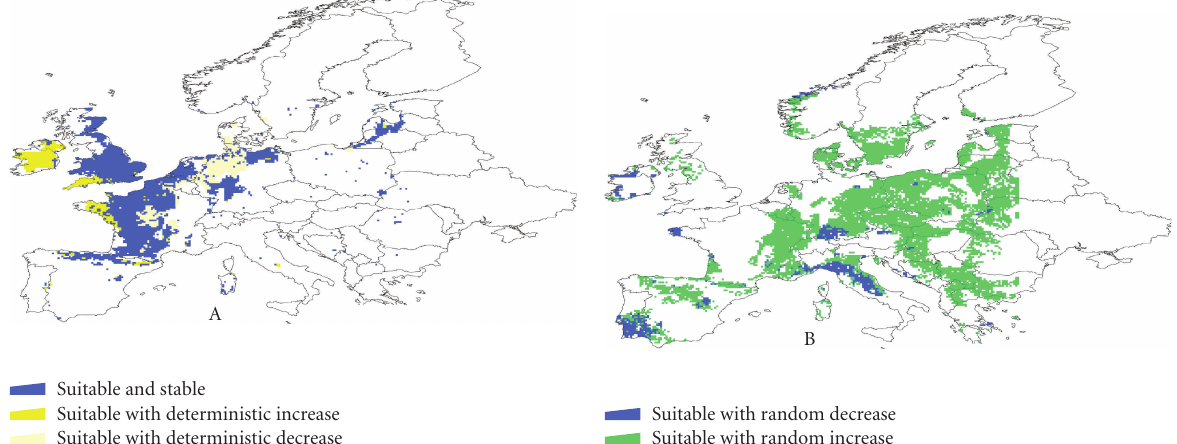
Figure 4: An analysis of the long-term changes in climate suitability for the tick Ixodes ricinus in Europe (1900–1999). A temporally extensively gridded dataset was subjected to a temporal analysis to understand how climate has changed in 100 years and how this trend a ff ected the climate suitability for the tick. Areas are divided into suitable and unsuitable (the last, without colors in the figure). In the panel “A,” the area marked as suitable and stable means no changes in suitability for the tick. Deterministic increase or decrease means a continued trend towards increasing or decreasing climate suitability. Panel B shows the areas where random walk trend has been observed. These areas are subjected to periodic cycles of climate, thus allowing cycles of increasing or decreasing climate suitability for the tick. (Estrada-Pe˜na and Venzal 2006 [50], with permission from Ecohealth